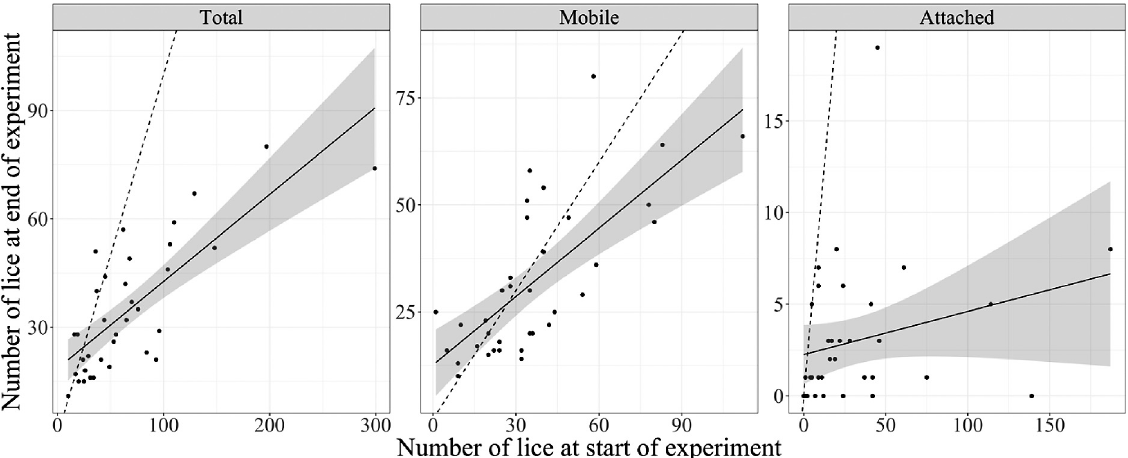
Fig. 6. Cross-plot of end-of-trial vs. start-of-trial louse abundance on Salmo trutta , for (a) all louse stages, (b) mobile louse stages, and (c) attached louse stages, fitted with a smoothing line (solid black line) and estimated confidence intervals (shaded grey). Dashed line represents 1:1 line (i.e. no change from start to